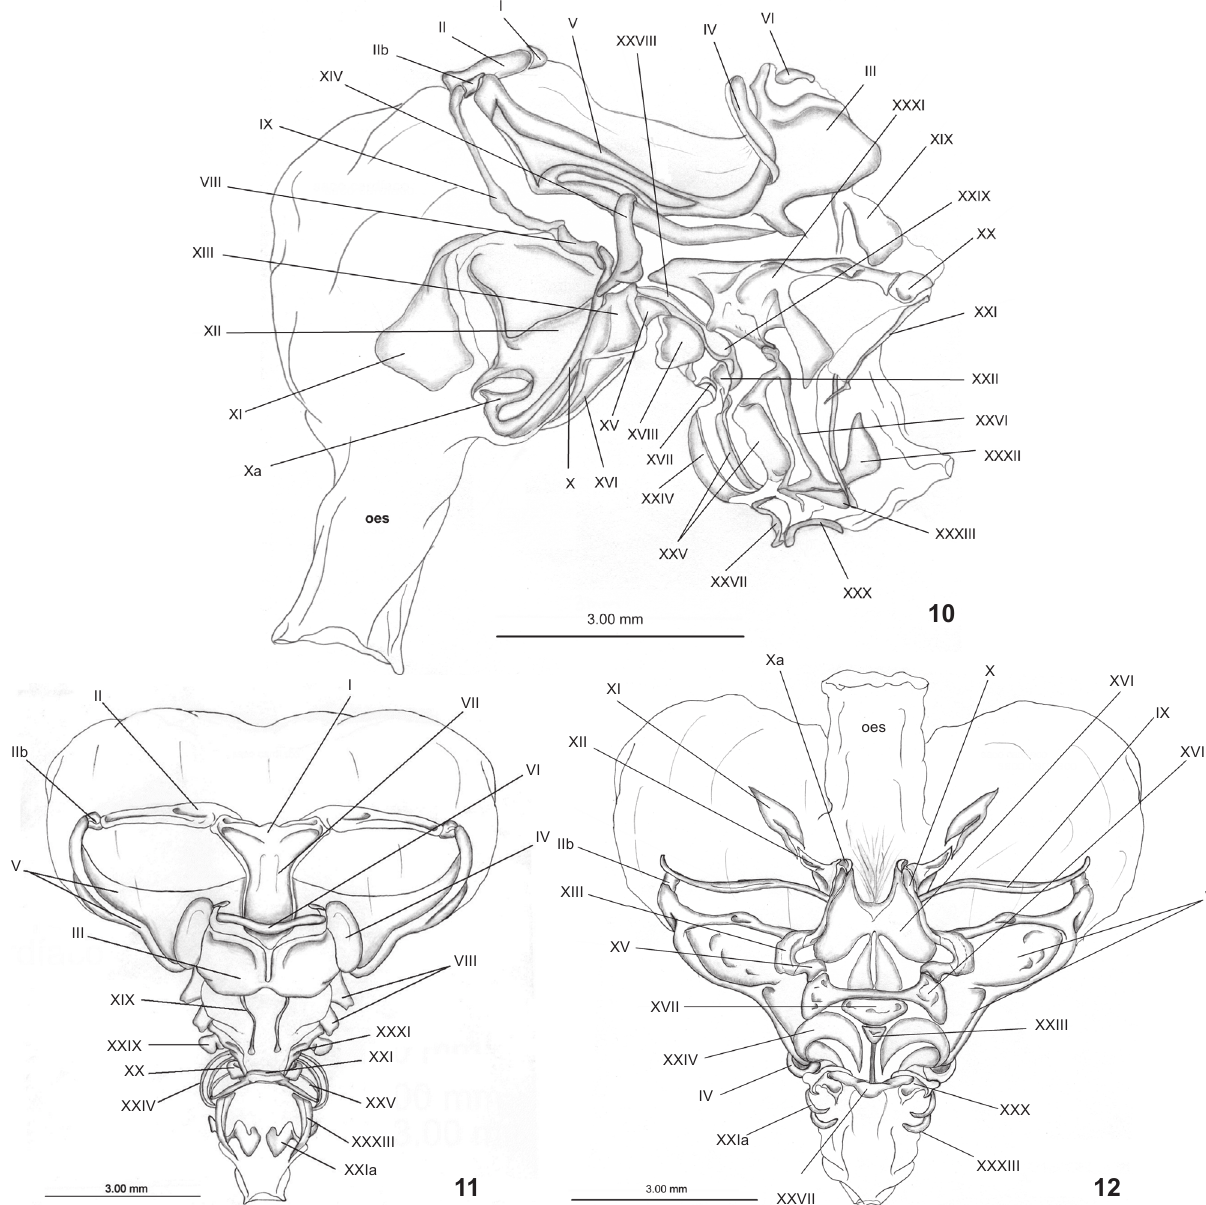
Figures 10-12. Dilocarcinus septemdentatus , cardiac and pyloric chambers of the foregut: (10) lateral view; (11) dorsal view; (12) ventral view. Mesocardiac ossicle (I), pterocardiac ossicle (II), postpterocardiac ossicle (IIb), pyloric ossicle (III), exopyloric ossicle (IV), zygocardiac ossicle (V), propyloric ossicle (VI), pectineal ossicle (VIII), prepectineal ossicle (IX), postpectineal ossicle (X), ‘Quill’ of the postpectineal ossicle (Xa), anterior lateral cardiac plate (XI), posterior lateral cardiac plate (XII), inferior lateral cardiac ossicle (XIII), subdentate ossicle (XIV), lateral cardio-pyloric ossicle (XV), ossicle of the cardio-pyloric valve (XVI), anterior ossicle of the cardio-pyloric valve (XVI), poste- rior ossicle of the cardio-pyloric valve (XVII), lateral ossicle of the cardio-pyloric valve (XVIII), anterior mesopyloric ossicle (XIX), posterior mesopyloric ossicle (XX), uropyloric ossicle (XXI), preampullary ossicle (XXII), anterior inferior pyloric ossicle (XXIII), inferior ampullary ossicle (XXIV), ampullary roof ossicle, lower portion ossicle (XXV), ampullary roof ossicle, upper portion ossicle (XXVI), posterior inferior pyloric ossicle (XXVII), anterior supra-ampullary ossicle (XXVIII), middle supra-ampullary ossicle (XXIX), posterior supra-ampullary os- sicle (XXX), anterior pleuropyloric ossicle (XXXI), middle pleuropyloric ossicle (XXXII), posterior pleuropyloric ossicle